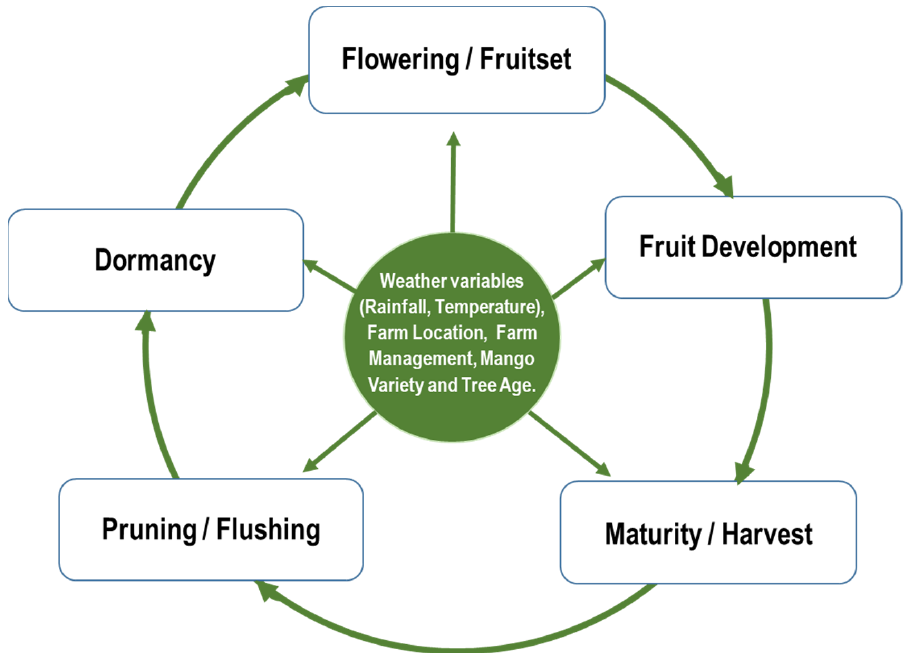
Figure 2. Main phenology stages of mango in Ghana.